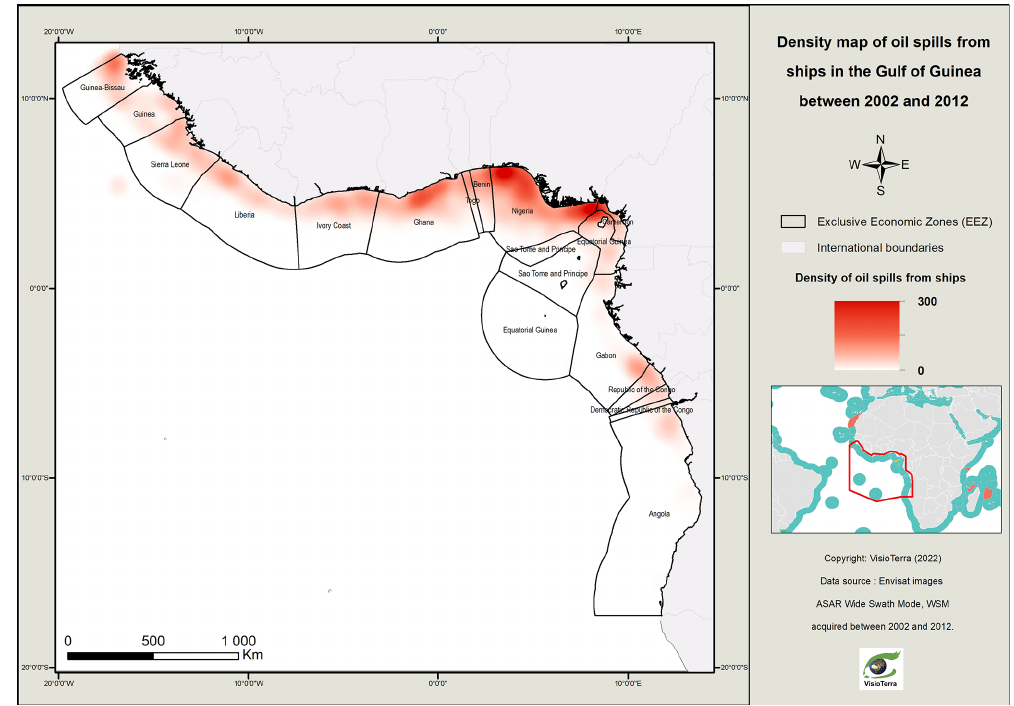
Figure 13. Density map of oil spills from ships in the Gulf of Guinea between 2002 and 2012.